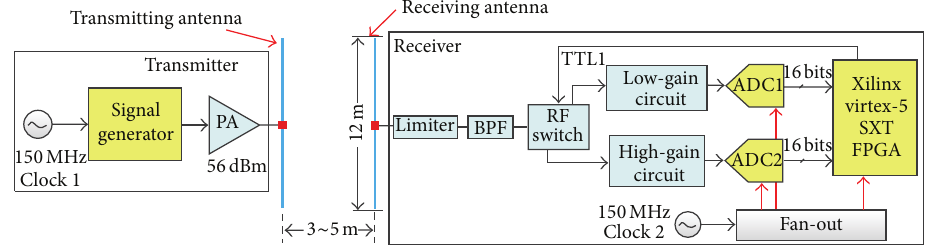
Figure 1: The architecture of our developed low-frequency coded GPR.